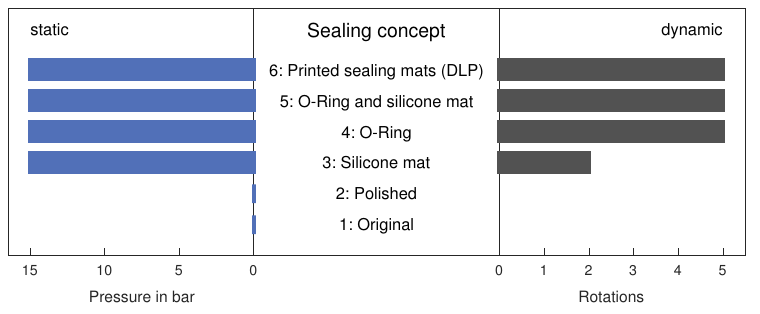
Figure 5. Comparison of tested sealing concepts; ( left ) pressure stability of respective sealing concepts (static sealing test); ( right ) influence of number of rotations on tightness of test valves (dynamic sealing